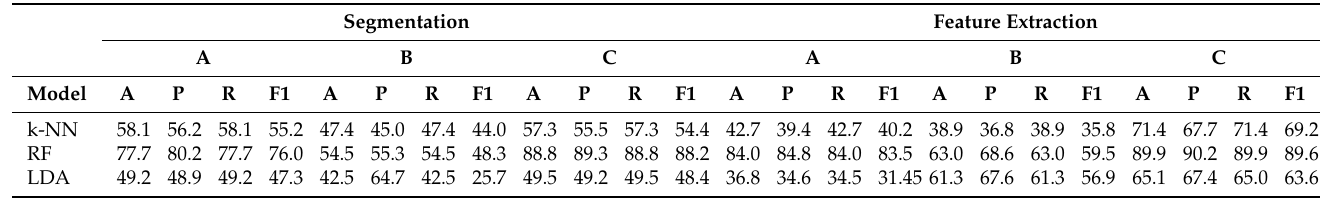
Table 4. Average results for segmentation and feature-extraction data representation of all 12 subjects’